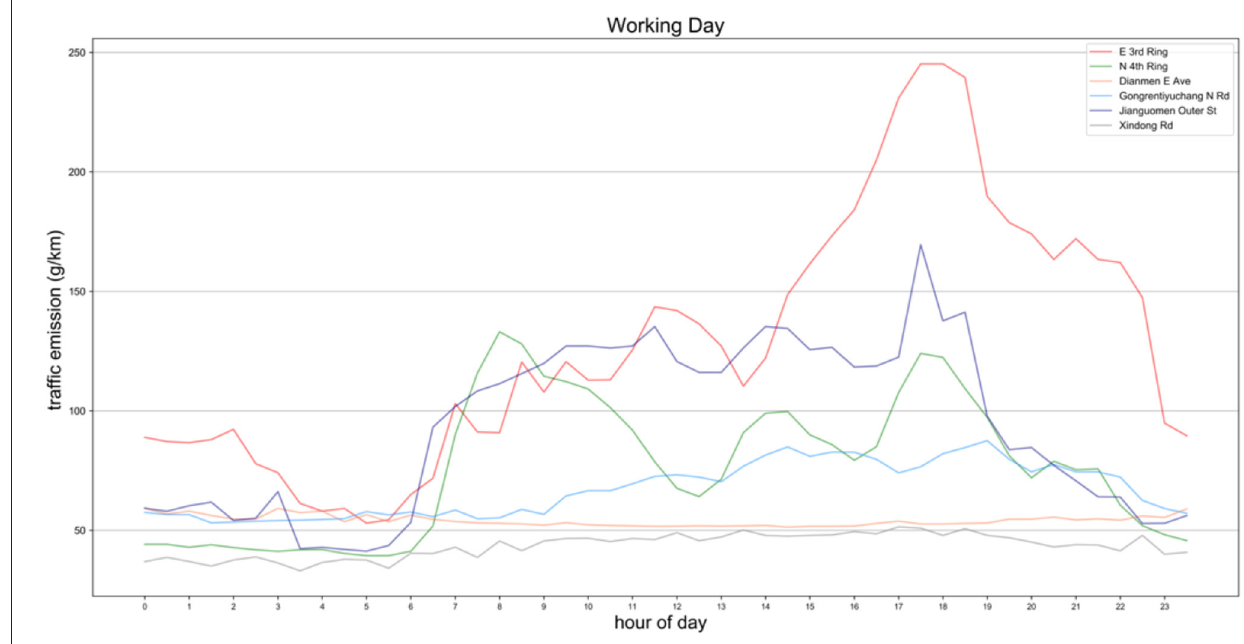
FIGURE 11 | Working day traffic emissions from selected typical roads in four regions.